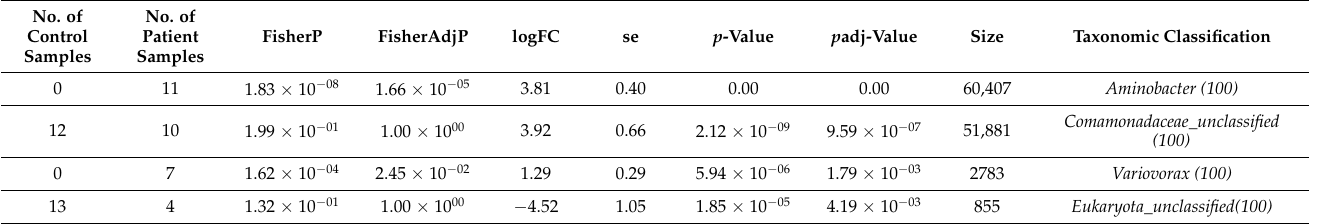
Table 3. Presence/absence and abundance differences of bacteria, as determined by Fisher’s exact test and